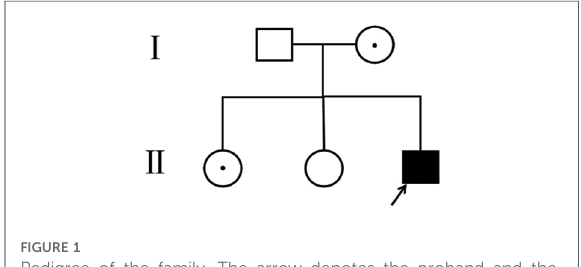
FIGURE 2 The changes in the amniotic fl uid index during pregnancy for the patient with an MAGED2 variant during pregnancy. (The normal range of amniotic fl uid index is 8 – 25 cm, as shown in the shaded